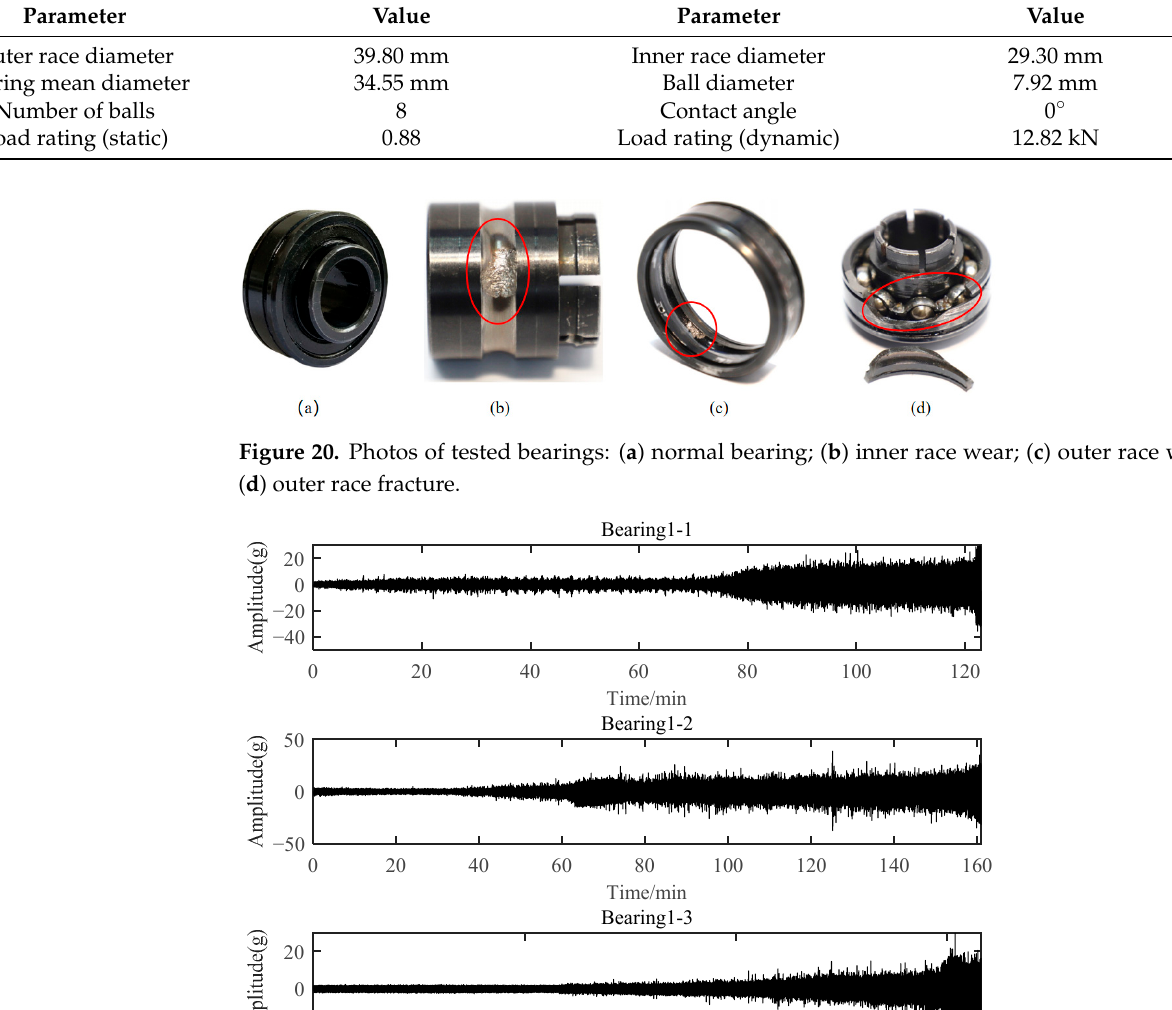
Figure 21. Horizontal vibration signal of three bearings.